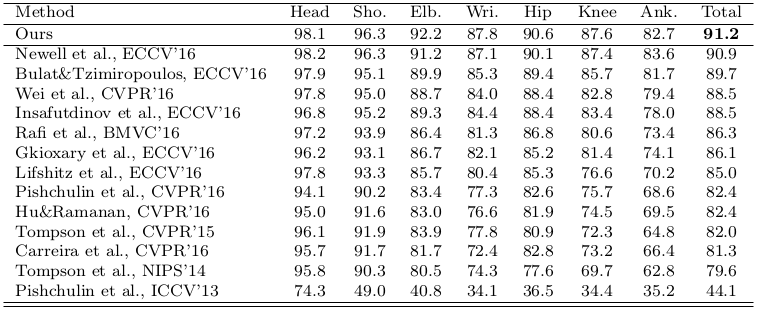
Table from the paper: Knowledge-Guided Deep Fractal Neural Networks for Human Pose Estimation
Table text:
Method
Head
Sho.
Elb.
Wri.
Hip
Knee
Ank.
Total
Ours
98.1
96.3
92.2
87.8
90.6
87.6
82.7
91.2
Newell et al., ECCV’16
98.2
96.3
91.2
87.1
90.1
87.4
83.6
90.9
Bulat&Tzimiropoulos, ECCV’16
97.9
95.1
89.9
85.3
89.4
85.7
81.7
89.7
Wei et al., CVPR’16
97.8
95.0
88.7
84.0
88.4
82.8
79.4
88.5
Insafutdinov et al., ECCV’16
96.8
95.2
89.3
84.4
88.4
83.4
78.0
88.5
Raﬁ et al., BMVC’16
97.2
93.9
86.4
81.3
86.8
80.6
73.4
86.3
Gkioxary et al., ECCV’16
96.2
93.1
86.7
82.1
85.2
81.4
74.1
86.1
Lifshitz et al., ECCV’16
97.8
93.3
85.7
80.4
85.3
76.6
70.2
85.0
Pishchulin et al., CVPR’16
94.1
90.2
83.4
77.3
82.6
75.7
68.6
82.4
Hu&Ramanan, CVPR’16
95.0
91.6
83.0
76.6
81.9
74.5
69.5
82.4
Tompson et al., CVPR’15
96.1
91.9
83.9
77.8
80.9
72.3
64.8
82.0
Carreira et al., CVPR’16
95.7
91.7
81.7
72.4
82.8
73.2
66.4
81.3
Tompson et al., NIPS’14
95.8
90.3
80.5
74.3
77.6
69.7
62.8
79.6
Pishchulin et al., ICCV’13
74.3
49.0
40.8
34.1
36.5
34.4
35.2
44.1